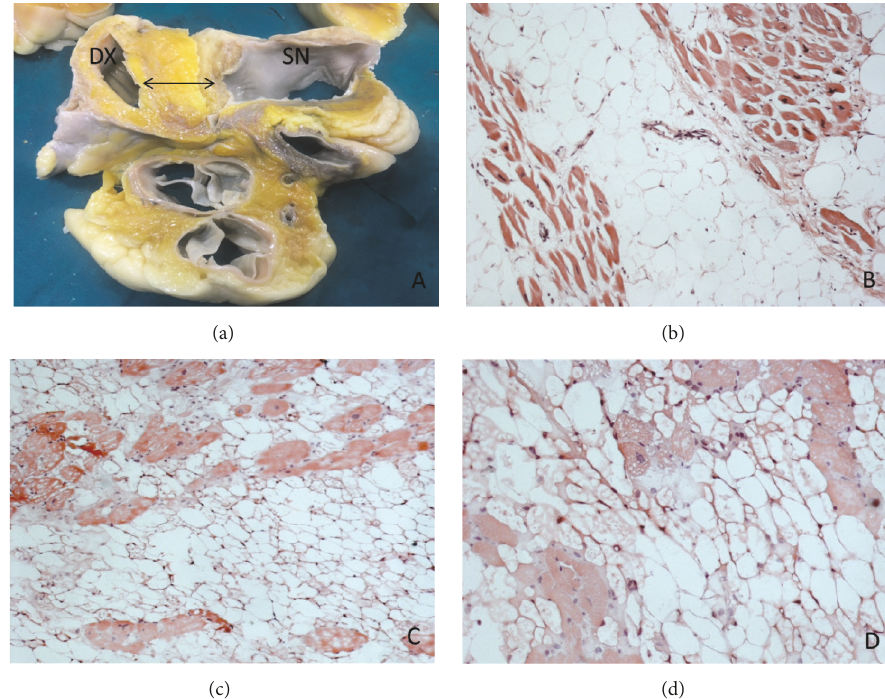
Figure 1: Macroscopic appearance of the lesion observed at autopsy (a) and histological overview showing extensive fat entrapping cardiomyocytes from atrial lesion of the first case (b) and from the interatrial septum of the second (c-d). Haematoxylin and Eosin 10X (b-c); Haematoxylin and Eosin 20X